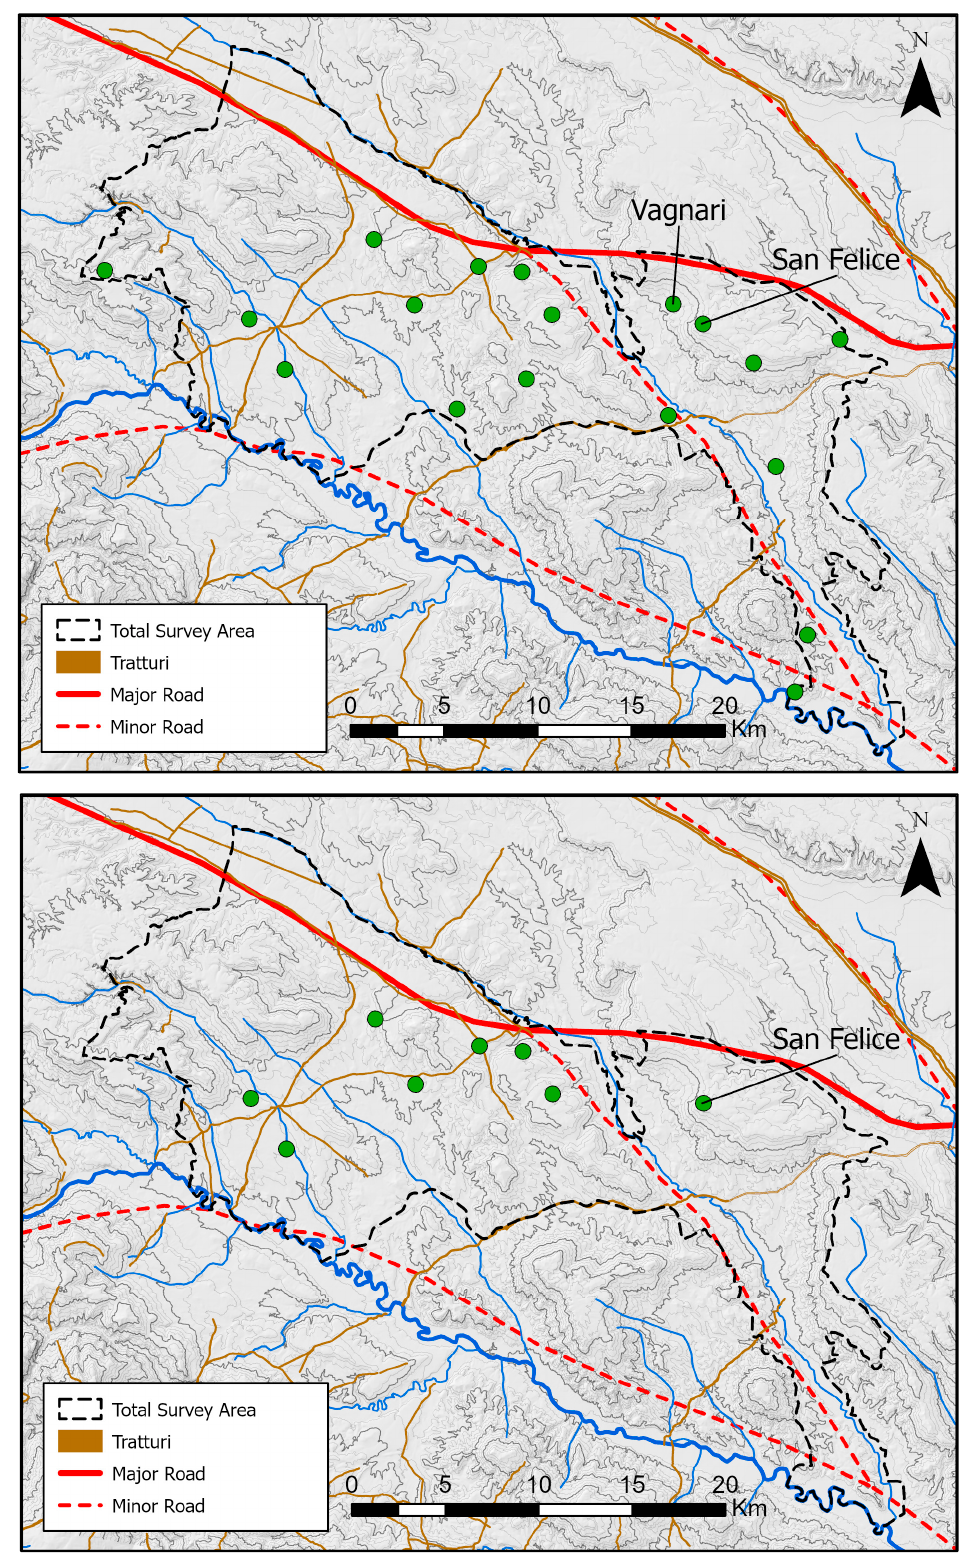
Figure 8. Agglomerated settlements occupied in the sixth ( top ) and the eighth centuries ( bottom ). Why were agglomerated settlements so prolific in the Basentello landscape over our period? Self-organizing rustici , increasingly unburdened by Rome and only marginally influenced by the church, settled in ways that maintained this complex adaptive system